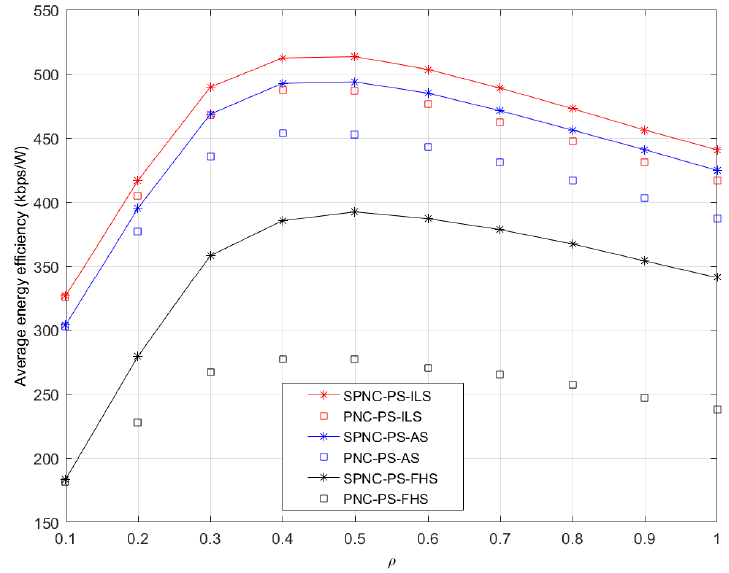
Figure 7. Average energy efficiency performance versus different PS coefficients ρ in PS aided two-way satellite-terrestrial relay network with ILS, AS, and